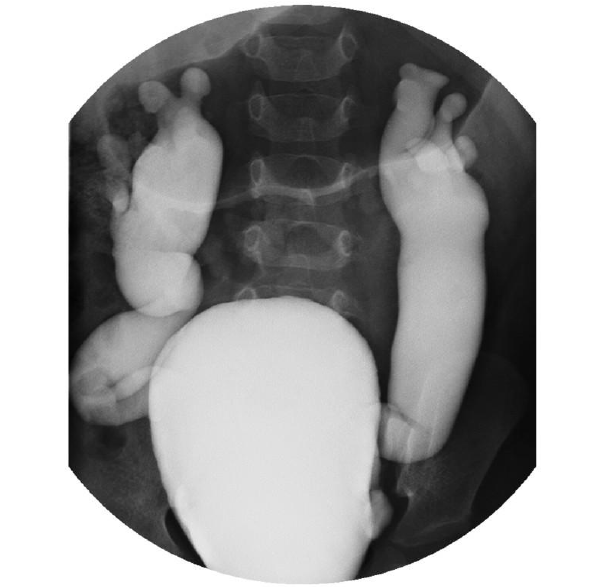
FIGURE 3. Voiding cystourethrogram demonstrating megacystis megaureter, with bilateral high-grade reflux.